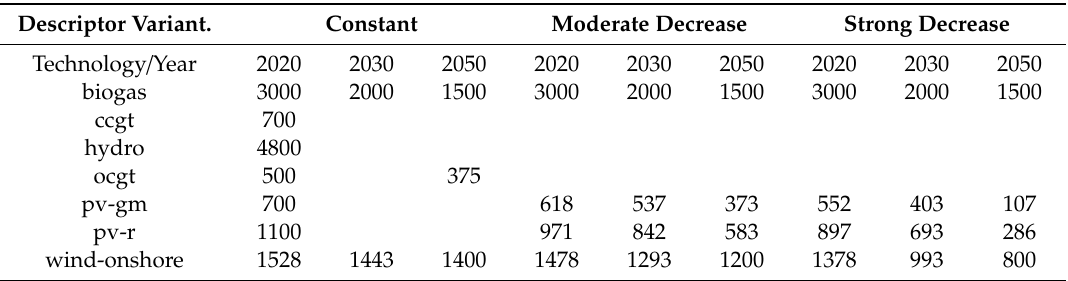
Table A2. Assumptions of CAPEX cost per technology in the di ff erent descriptor variants in € 2018 / kW. Descriptor